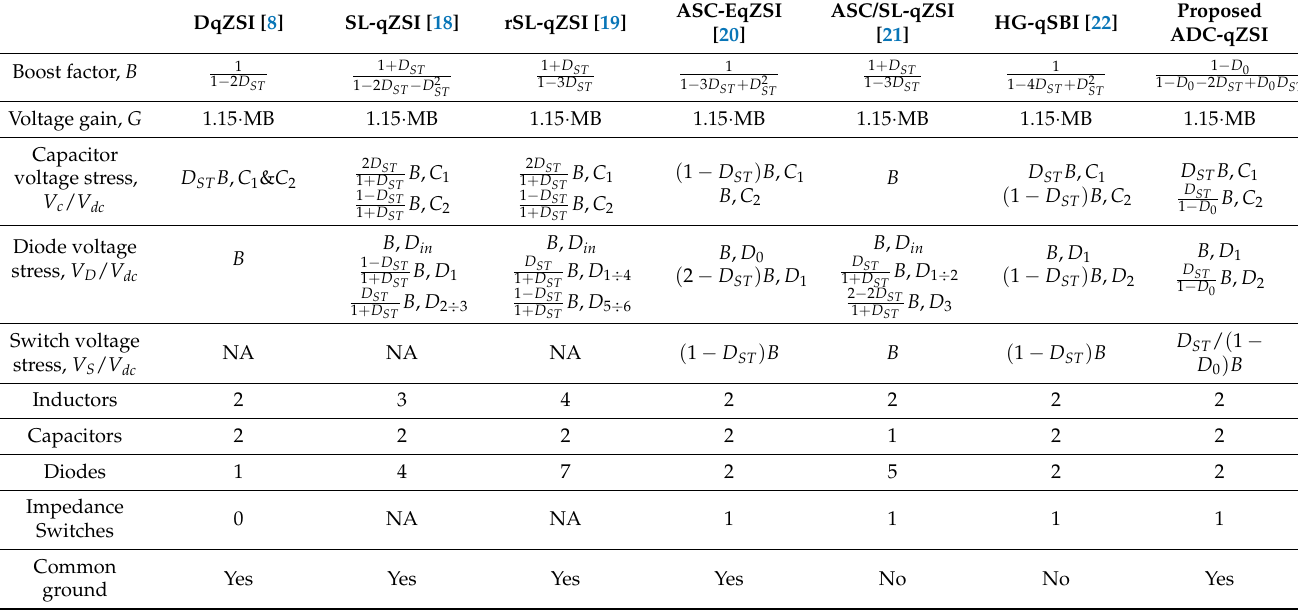
Table 3. Overall Comparison Between Proposed Inverter and Other Single-Stage Inverters.